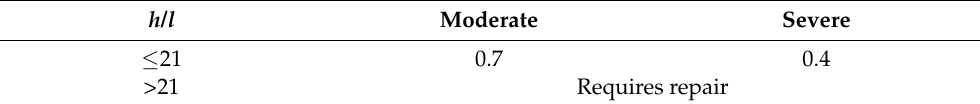
Table 8. Value for reduction factor R 2 by type of damage